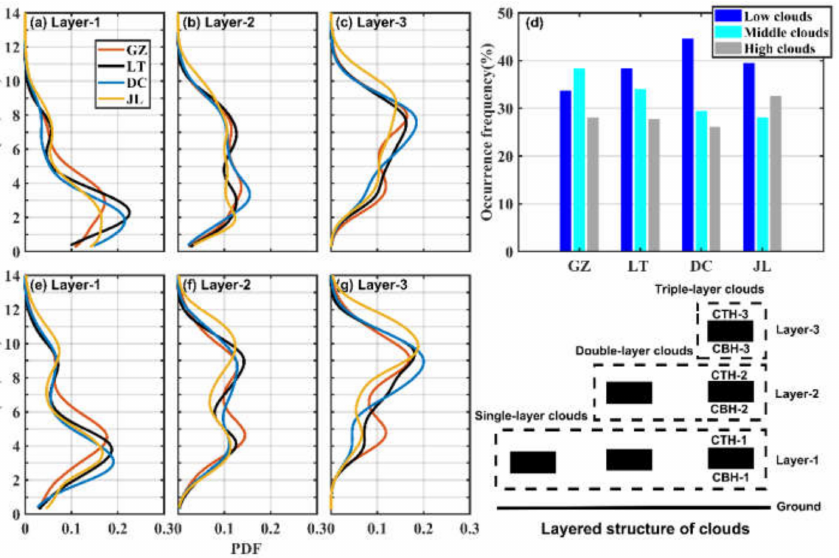
Figure 8. The PDF of the base height and top height from different layer clouds, and the result of cloud classification. ( a – c ) CBH; ( d ) clouds classification results; ( e – g ) CTH. ( a , e ) Layer-1; ( b , f ) Layer-2; ( c , g )